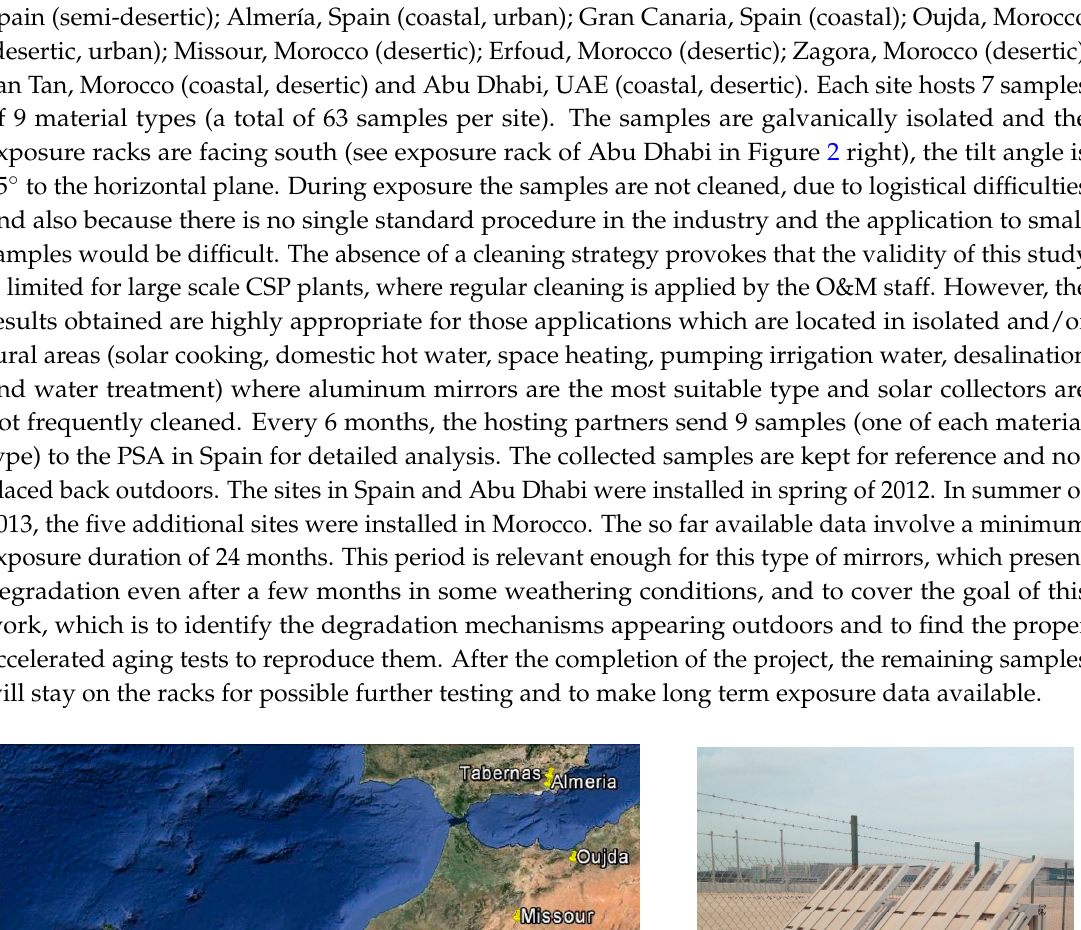
Table 2. Description of performed accelerated aging tests.